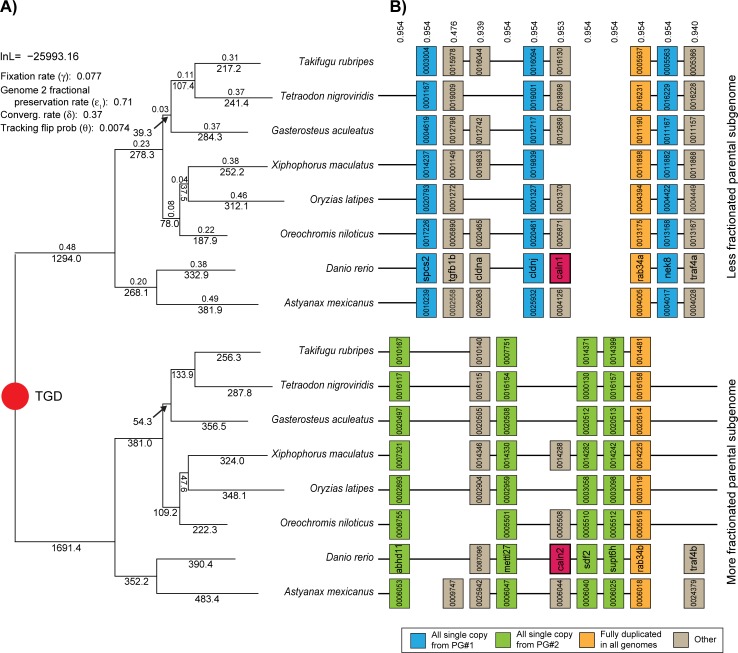
Resolution of the TGD through ohnolog losses.A) Shown is the assumed phylogeny of the eight species analyzed (see Methods). The TGD induces two mirrored gene trees, corresponding to the genes from the less fractionated parental genome (top) and the more fractionated parental genome (bottom, see Results for tests of the significance of the level of biased fractionation). Below the branches in each tree are POInT’s predicted number of gene losses along that branch for the parental genome in question. Above the branches in the upper tree are POInT’s branch length estimates, namely t (time) multiplied by the α parameter in Fig 2. Here αt corresponds to the overall estimated level of gene loss on that branch: a larger αt implies a greater number of losses relative to the total number of surviving ohnologs at the start of the branch. In the upper left are POInT’s parameter estimates (γ,ε1,δ) for the WGD-bcnbnf model (see Fig 2). B) An example region of the eight genomes, showing the blocks of DCS. For all species except zebrafish, truncated Ensembl gene identifiers are given; for zebrafish gene names are shown. The numbers above each column gives POInT’s confidence in the orthology relationship shown, relative to the 28−1 (= 255) other possible orthology relationships. These other relationships entail swapping the two tracks of genes from one or more of the genomes between the top and the bottom panel: the confidence estimates indicate how much worse a fit is induced by assuming a different set of subgenome assignments. Genes are color-coded based on the pattern of ohnolog survival in the eight genomes. A pair of ohnologs expressed in the zebrafish retina are shown in magenta.